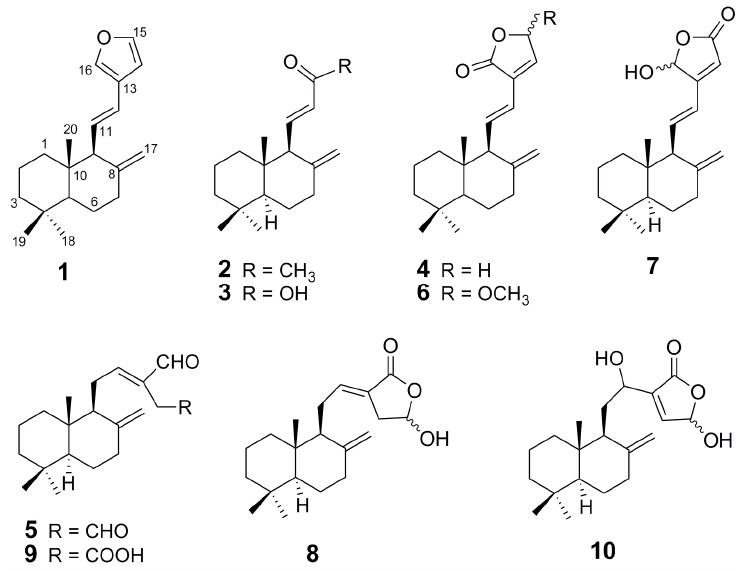
Figure 1. The structures of compounds 1 – 10 from H. ellipticum .